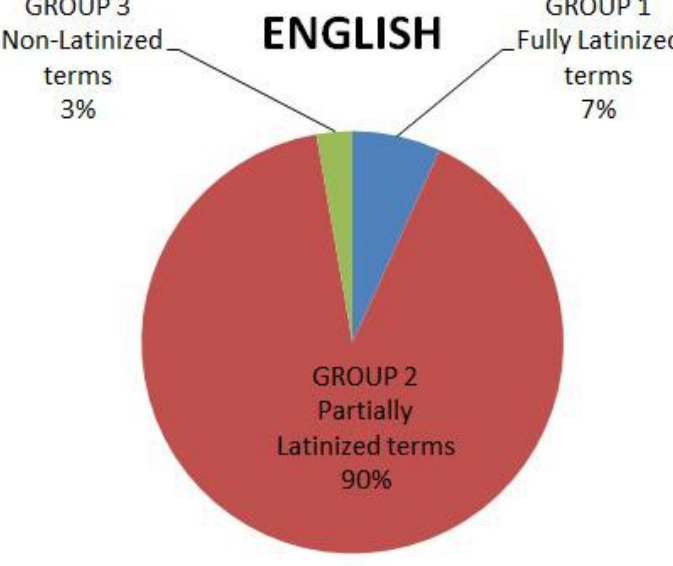
Figure 2 - The degree of Latinization of the English